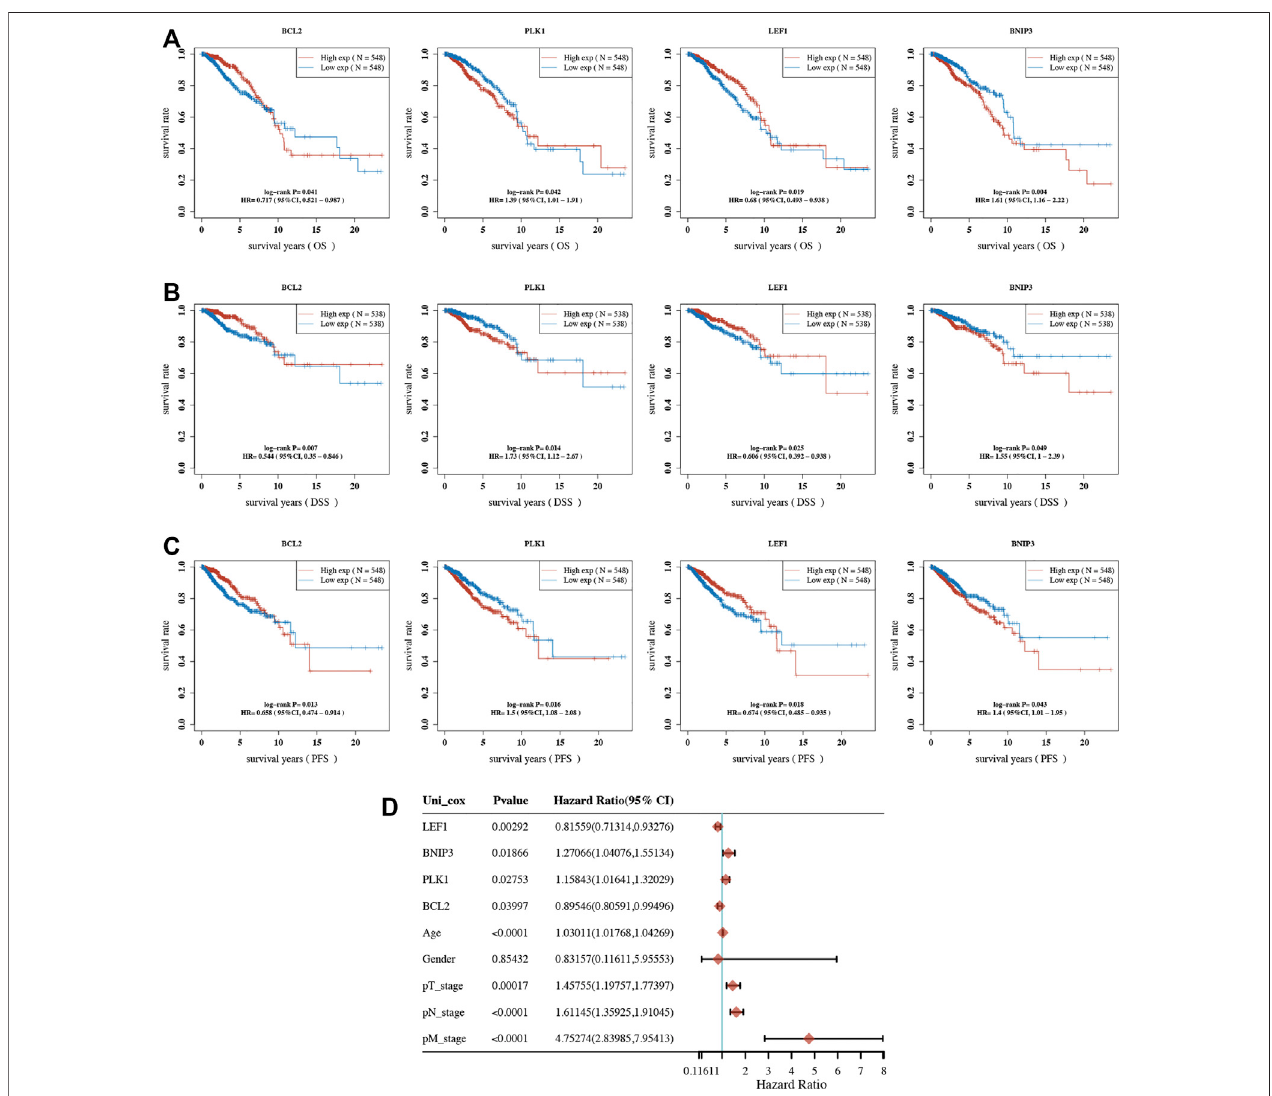
FIGURE 3 | Prognostic analysis of necroptosis-related gene in BRCA. OS (A) , DSS (B), and PFS (C) curve in BRCA patients with high/low expression of BCL2, PLK1, LEF1, and BNIP3. (D) Univariate survival analysis considering the expression of BCL2, PLK1, LEF1, and BNIP3 as well asclinical characters in BRCA. OS, overall survival; DSS, disease-speci fi c survival; PFS, progression-free